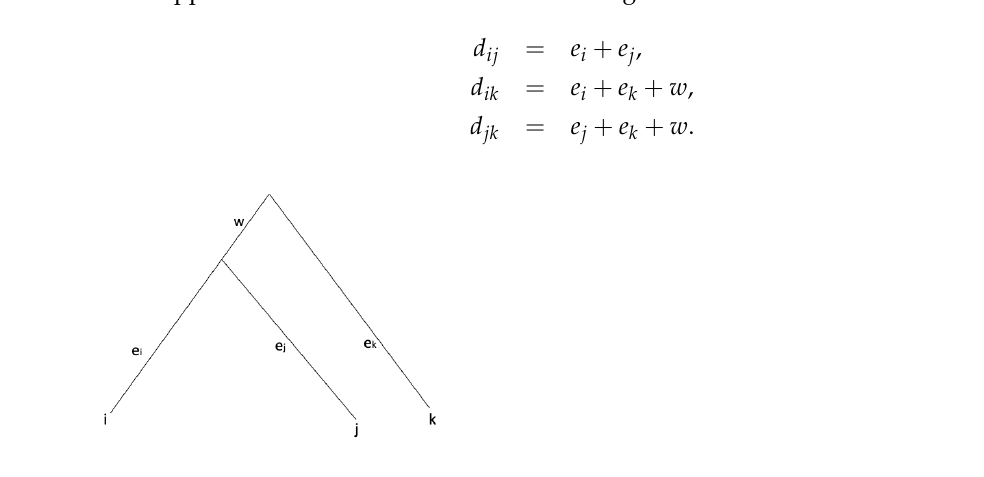
Figure 3. Equidistant tree with three leaves on labels X = { i , j , k } . w , e i , e j , e k > 0 are branch